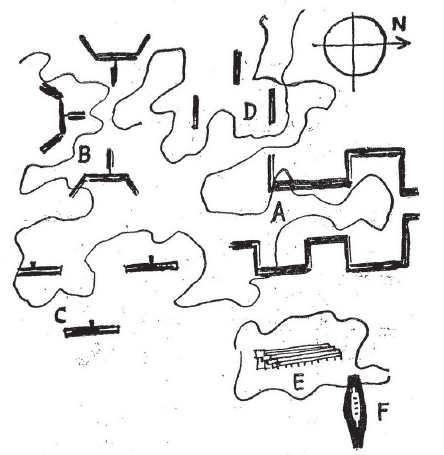
Fig. 8. Le Corbusier, Urbanisme des trois établissements